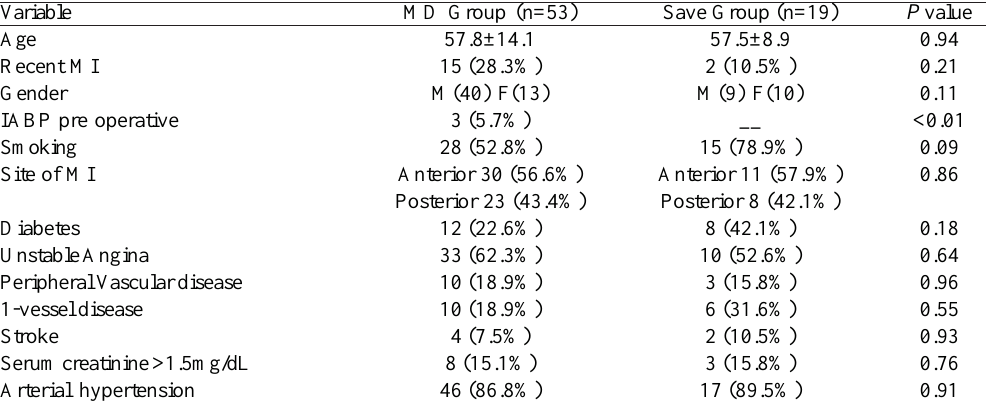
Table 1. Patients demographic and preoperative